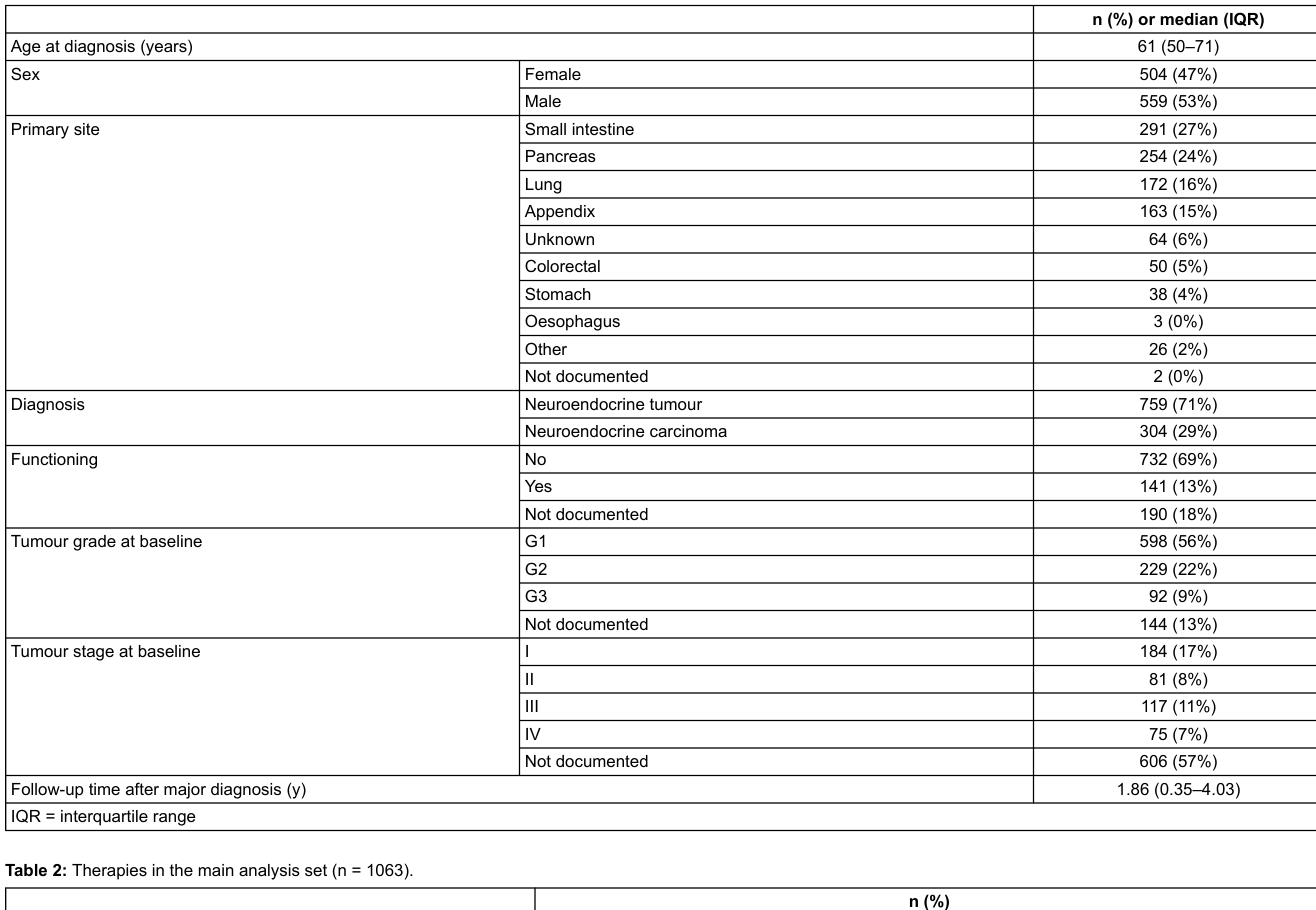
Table 1: Patient and tumour characteristics (n = 1063 patients).